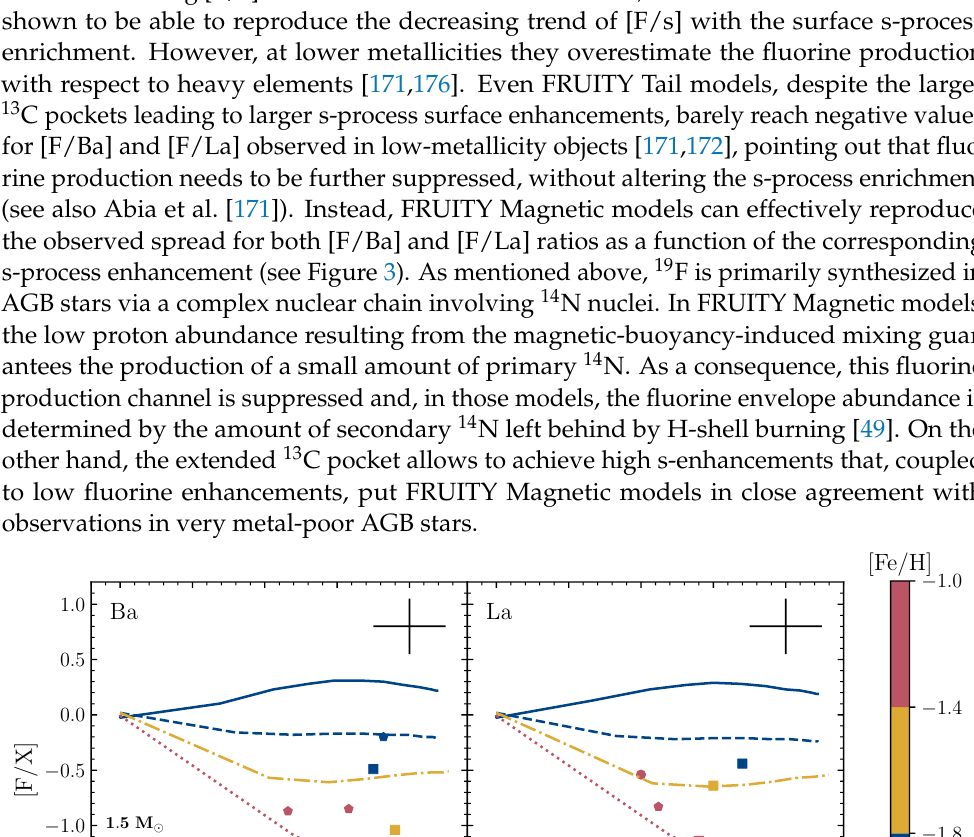
1.0. Symbols refer to three data ≤ −